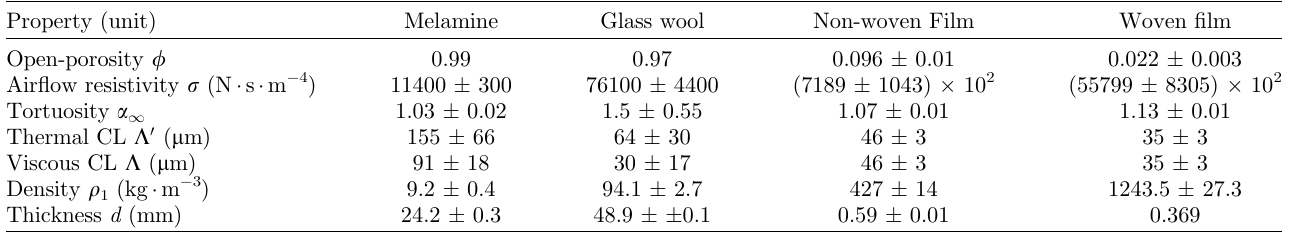
Table 2. Material properties from the characterisation process as a fi rst step to the experimental validation (see Sect. 4). Property (unit)